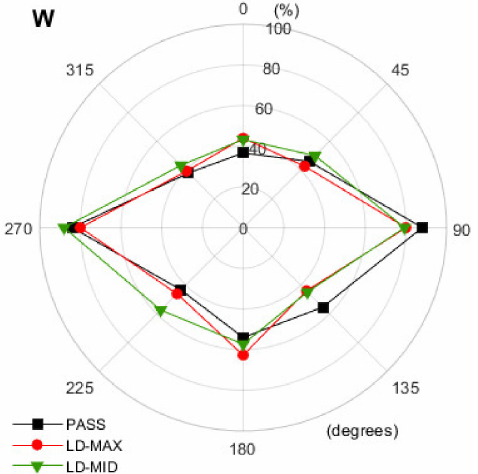
Figure 9. The values of the direction recognition index determined for different directions when using the W earplugs in different modes. PASS—with the level-dependent system switched off. LD-MAX—level-dependent mode, with maximum amplification in the sound transmission path; LD-MID—level-dependent mode with the amplification set to incomplete (approximately